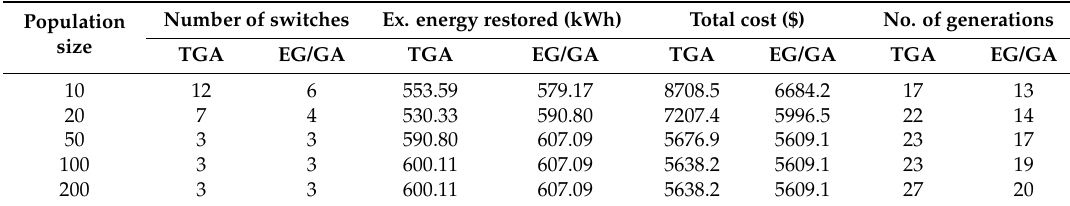
Table 5. Comparison of TGA and EG for Feeder 3.